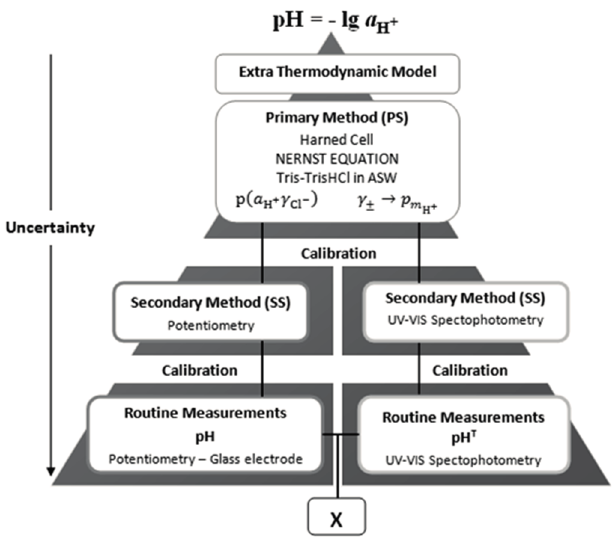
Figure 2. Schematic representation of a double traceability chain, showing traceability of two different types of analytical signals pertaining to hydrogen ion, H + , to common references of pH or p m H+ , and higher up to the conceptually defined pH